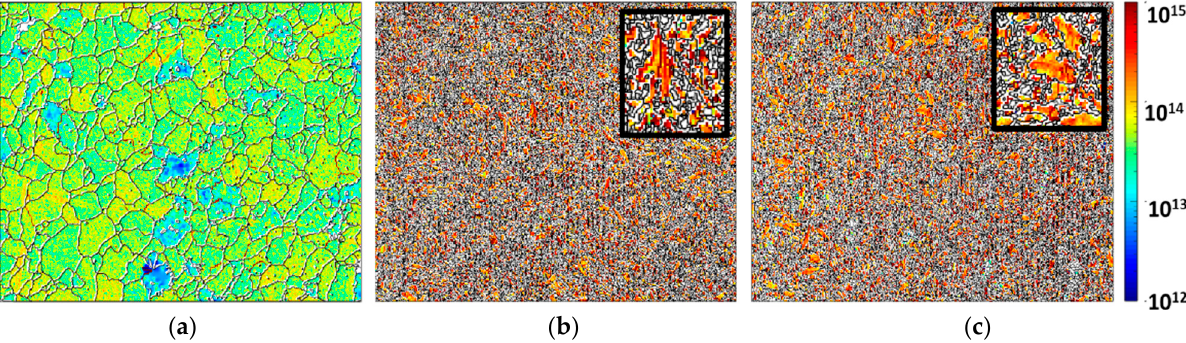
Figure 4. Geometrically necessary dislocation evolution of ( a ) untreated, ( b ) heated and ( c ) cryo-treated specimens. Figure 5 represents the grain size variation for untreated, conventionally heat-treated (heated) and 16 h cryogenically treated (cryo) specimens. The graph illustrates that the grain size is minimal for 16 h cryogenically treated H13 steel for both conditions (before and after corrosion). The cryogenic treatment assists in the precipitation of fine carbides along the grain boundaries which inhibits the grain growth, resulting in a fine-grained structure [39]. Minimum grain size depicts the maximum grain boundary area inside the material. It has been shown by some authors that the grain refinement leads to increased susceptibility to corrosion [40–42], but the passivity of the film present on the surface plays a vital role in deciding the response of the material to corrosion. When untreated specimens are compared with conventionally treated (heated) ones, there is a reduction in grain size and, as stated by some authors, the corrosion resistance would be greater if the passivity of the film is maintained even for a fine-grained material [43–45].